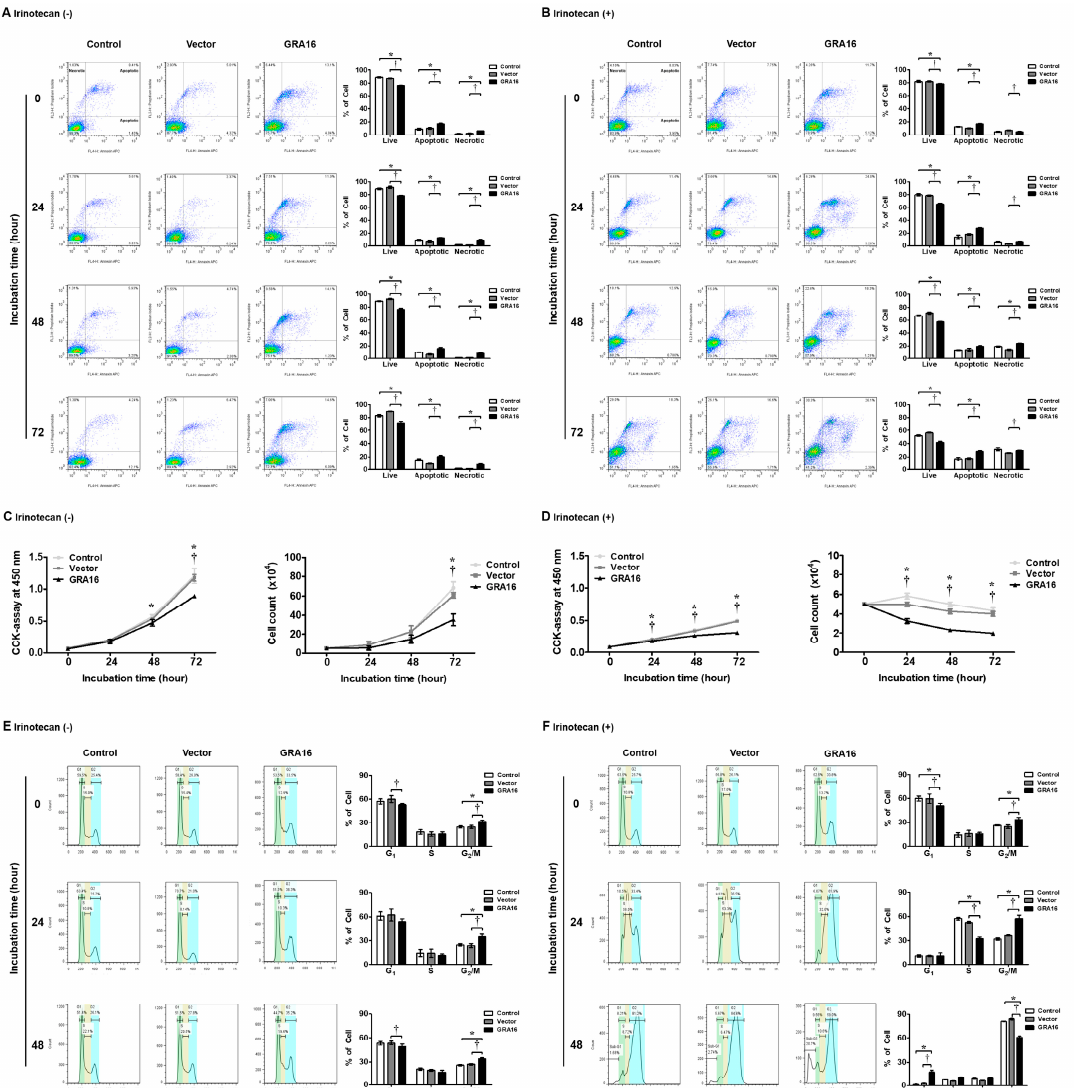
Figure 4. Effects of GRA16 and irinotecan on the induction of apoptosis and cell cycle arrest in non-small-cell lung carcinoma (NSCLC). Cell viability, cell cycle arrest, and cell apoptosis were investigated in GRA16 cells before and after irinotecan treatment using the CCK-8 assay and FACS analysis. ( A ) Annexin V and propidium iodide (PI) staining without irinotecan treatment. ( B ) Annexin V and PI staining under irinotecan treatment. ( C ) Cell viability and cell count (trypan blue exclusion test) without irinotecan treatment. ( D ) Cell viability and cell count under irinotecan treatment. ( E ) Cell cycle analysis via FACS without irinotecan treatment. ( F ) Cell cycle analysis via FACS under irinotecan treatment. * significant at p < 0.05 between control and GRA16 cells; † significant at p < 0.05 between vector and GRA16 cells.